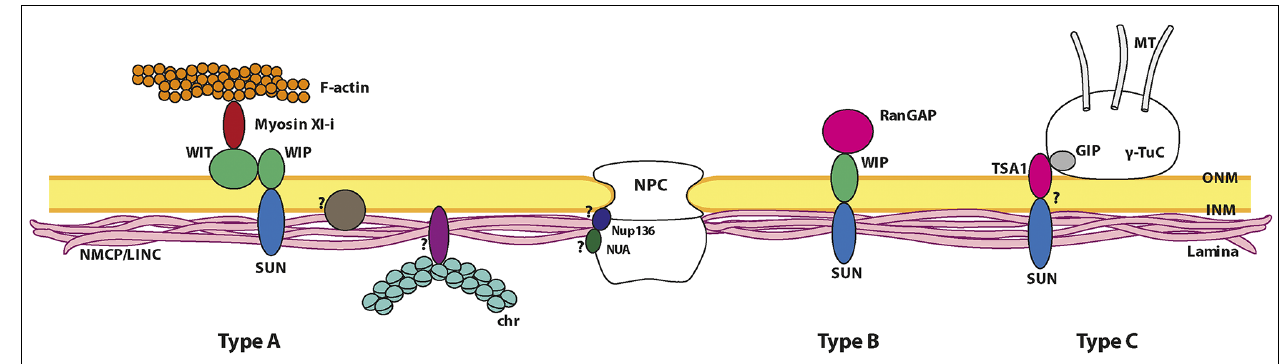
the WIT protein in the ONM, that in turn interacts with the SUN–WIP bridge (Tamura etal., 2013). The type B linker is formed by SUN proteins anchored to the INM that form a bridge with the WIPs in the ONM, which may in turn complex with WIT proteins in some cases. This type of complex is necessary for RanGAP to associate with the NE (Zhou etal., 2012; Zhou and Meier, 2013). Recently a model for the attachment of γ -TuCs ( γ -tubulin complexes) to the NE has been proposed (type C linker). In this complex, the interaction of a small component, GIP (GCP3-interacting protein), with TSA1, an ONM protein that contains a VIPt motif similar to the ϕ -VPT motif of WIPs, would facilitate an interaction with SUNs (Batzenschlager etal., 2013). Proteins in the different complexes are represented as monomers for simplification. Non-proven interactions are indicated by question